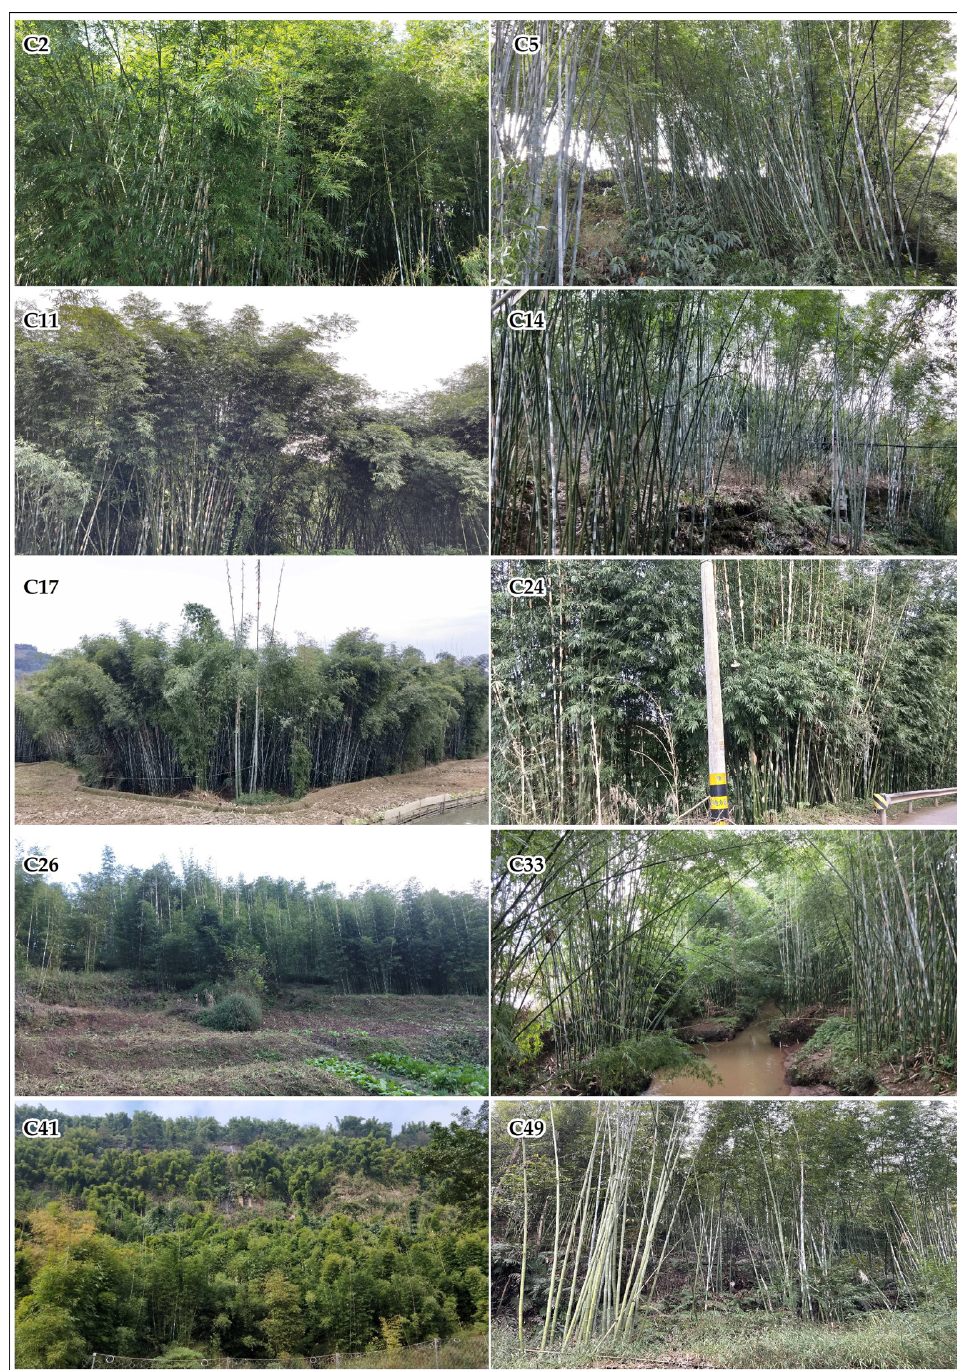
Figure A3. Photos of some Bambusa rigida validation points from the field survey.